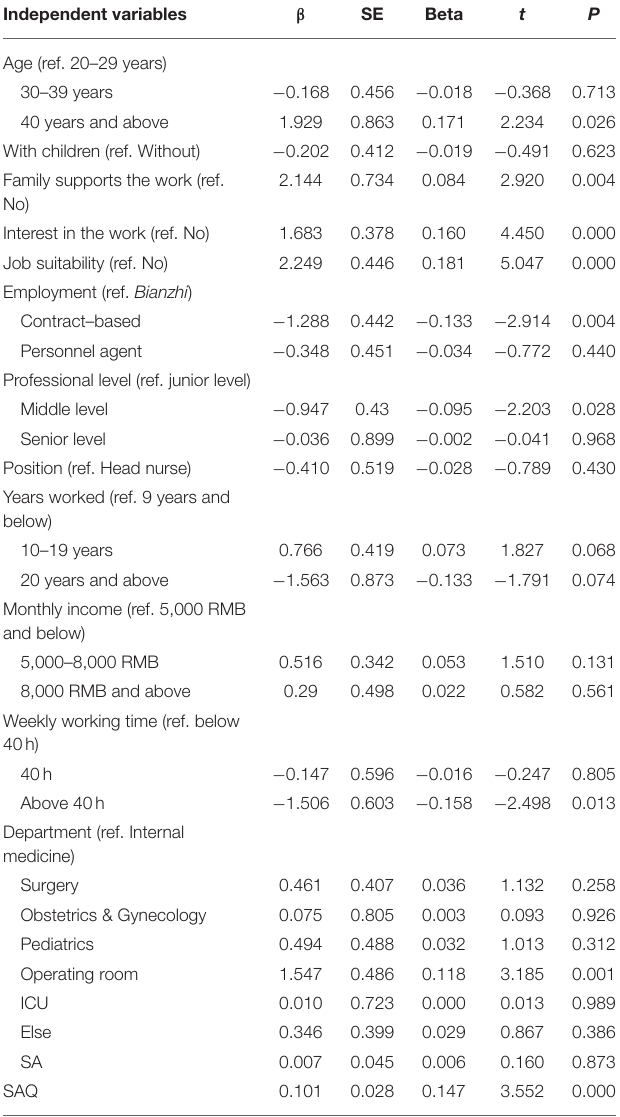
TABLE 5 | Multiple linear regression examining characters associated with intention to stay. Independent variables β SE